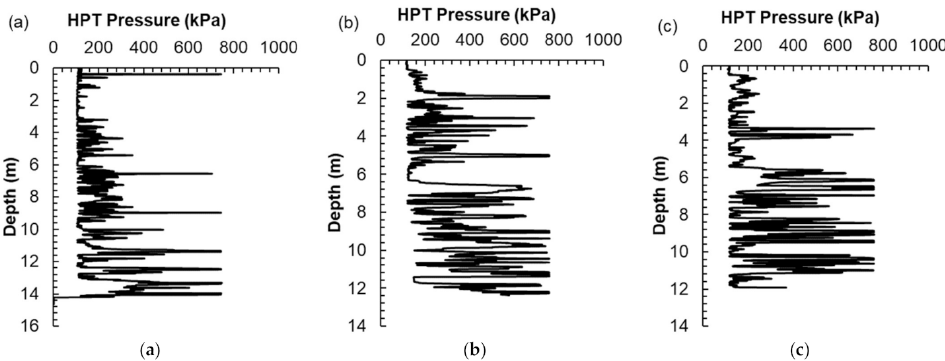
Figure 6. Profile of HPT pressure: ( a ) Butler County, ( b ) Sarpy County site 1, and ( c ) Sarpy County site 2.